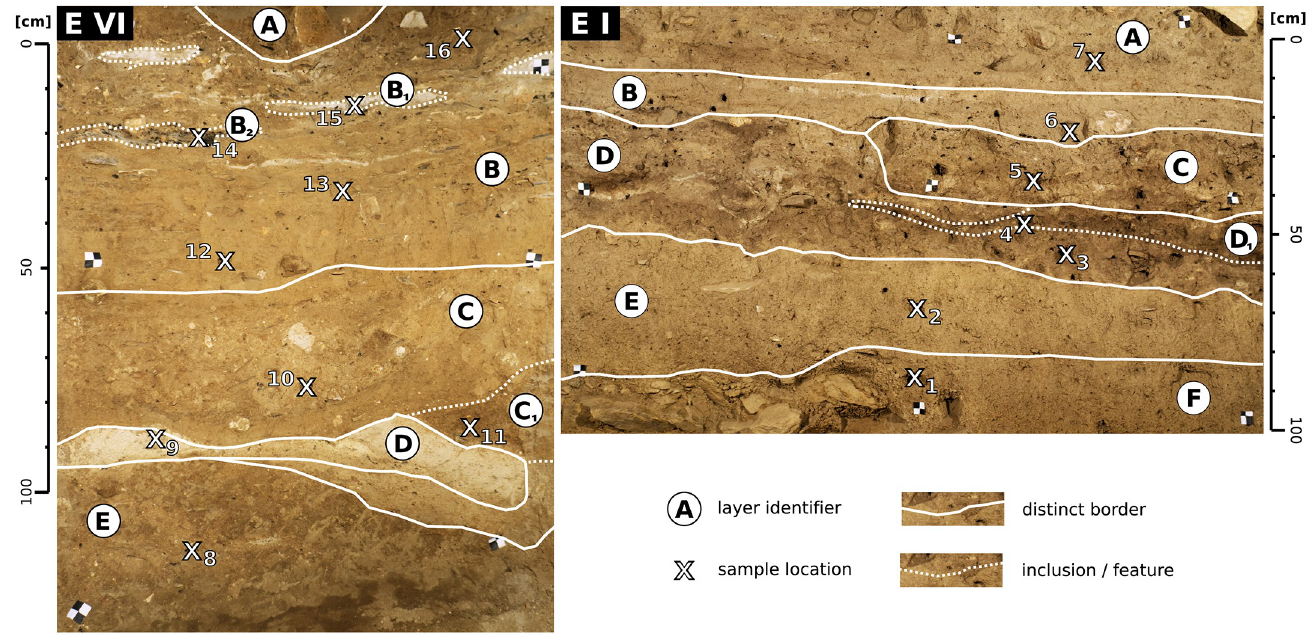
Fig 2. Archaeological profiles EI and EVI. The on-site stratigraphic interpretation is shown as white lines. Sediment samples were extracted at the 16 marked locations.